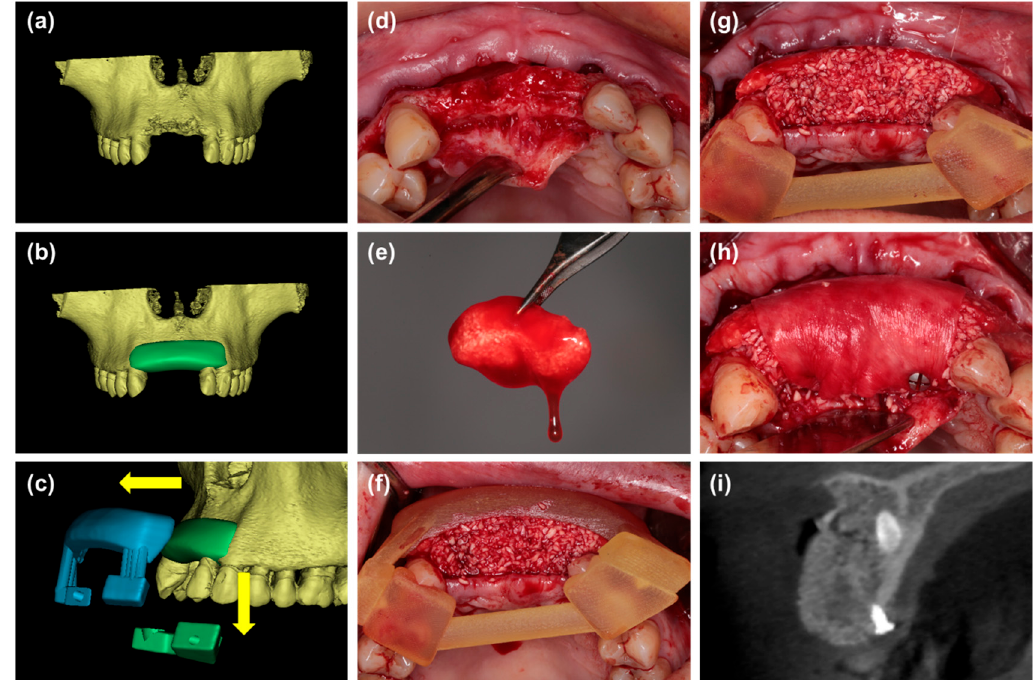
Figure 4. ( a , b ) Digital simulation of bone graft contour before surgery. ( c ) A two-piece surgical template, which consists of two parts: the coronal part (green) for retention and the labial part (blue) for shaping the bone grafts, was fabricated based on the digital model. the template can be removed without disrupting the graft material. ( d ) The labial defect could be observed. ( e ) Particulate bone substitutes were mixed with i-PRF. ( f , g ) The mixture of i-PRF and particulate bone substitutes was placed into the defect under the guidance of a surgical template to form customized sticky bone. ( h ) The customized sticky bone was covered with a collagen membrane and fixed with pins. ( i ) Radiographic view of cone beam CT immediately after wound closure.